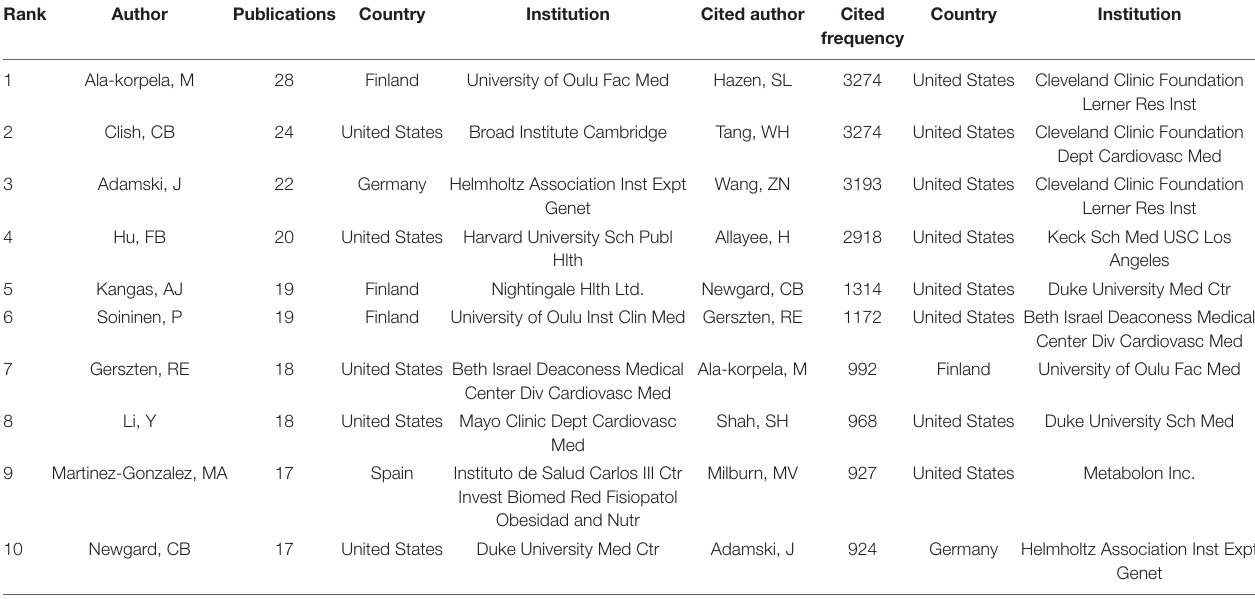
TABLE 3 | Top 10 authors distributed by publications and